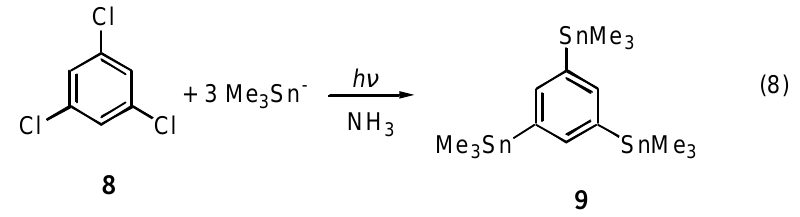
Table 1. Reactions of Me